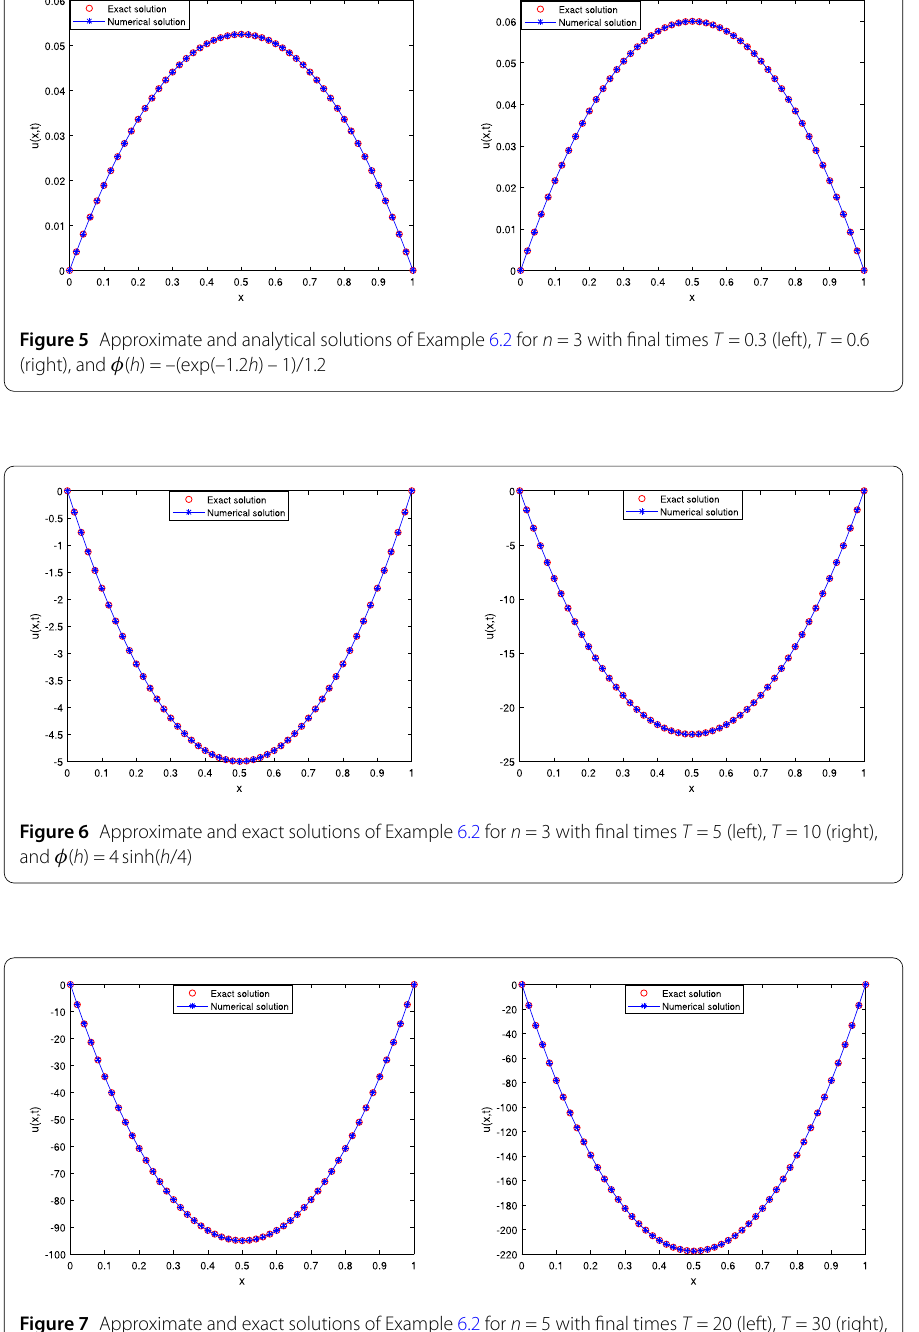
T = 10, respectively. Moreover, the last figure (Fig. 7) shows the analytical and approximate solutions of Example 6.2 for n = 5 and φ ( h ) = 2 sin ( h /2) with T = 20 and T = 30, respec- tively. Consequently, these obtained results show us the fact that our proposed method is efficient and gives a high accuracy for different